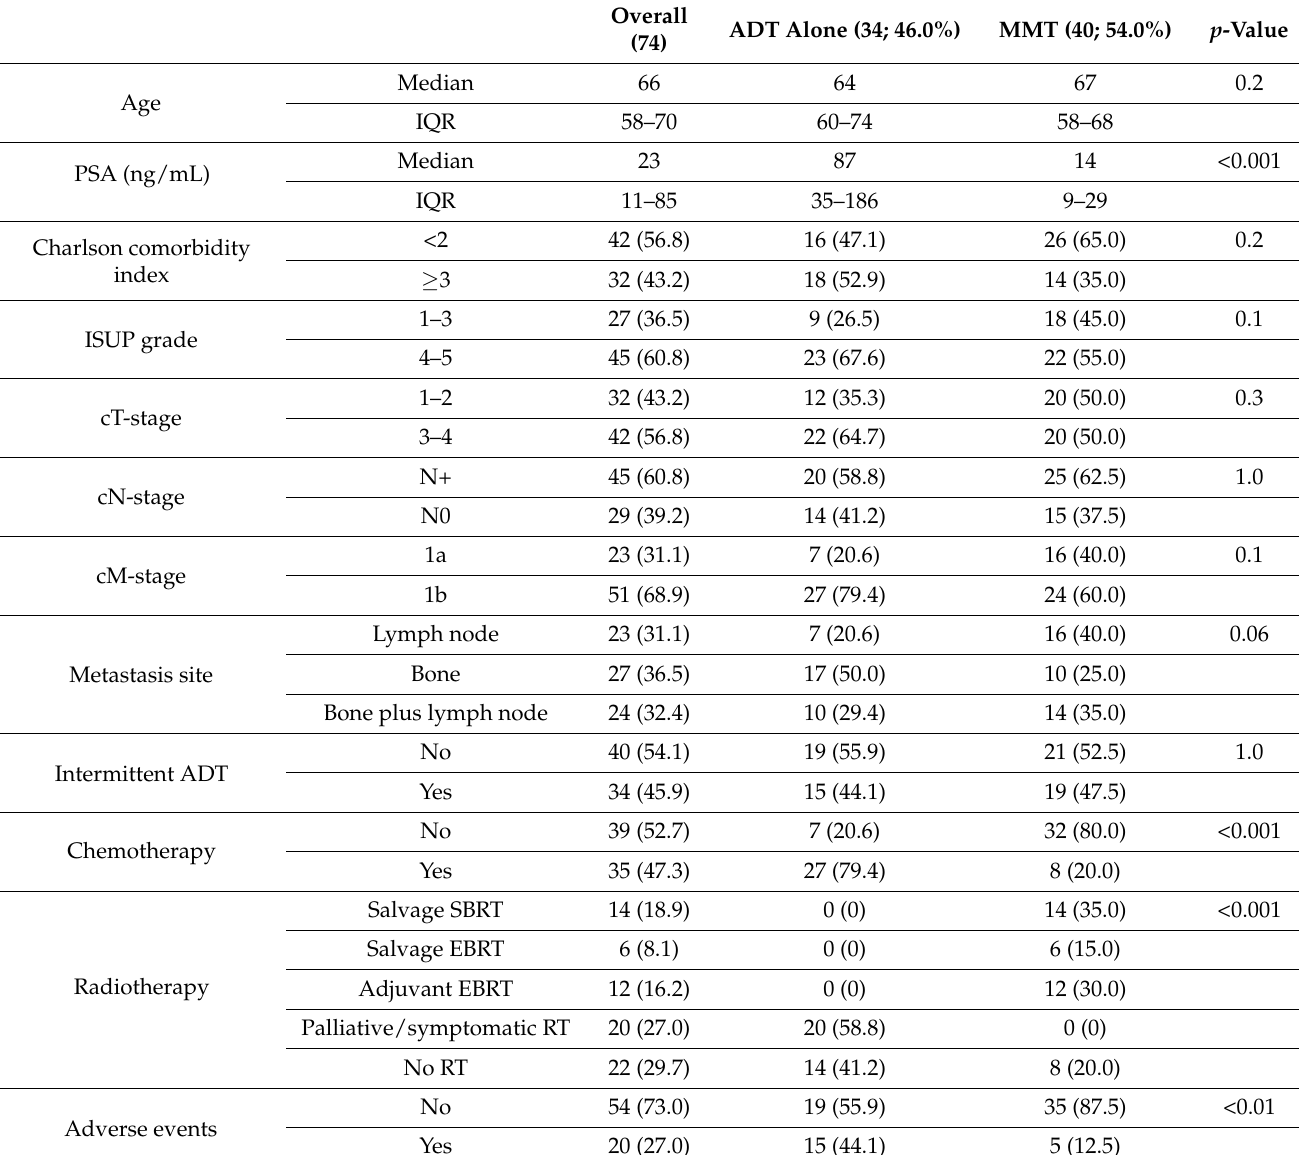
Table 1. Descriptive characteristics of 74 patients with oligometastatic prostate cancer stratified according to androgen deprivation therapy vs. multimodality